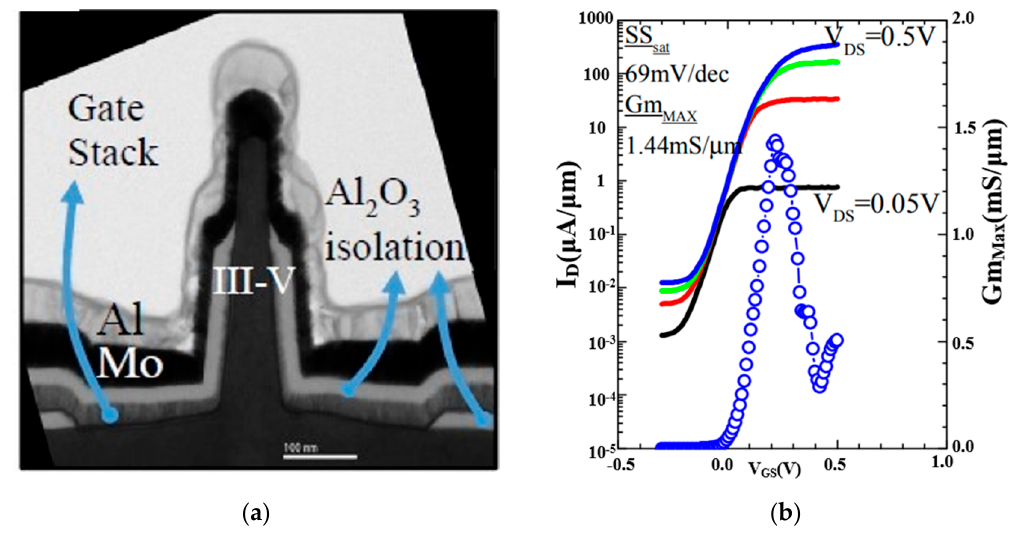
Figure 6. In 0.53 Ga 0.47 As nanosheet FET made by a top-down method: ( a ) TEM cross-section and ( b ) the transfer characteristics [45].